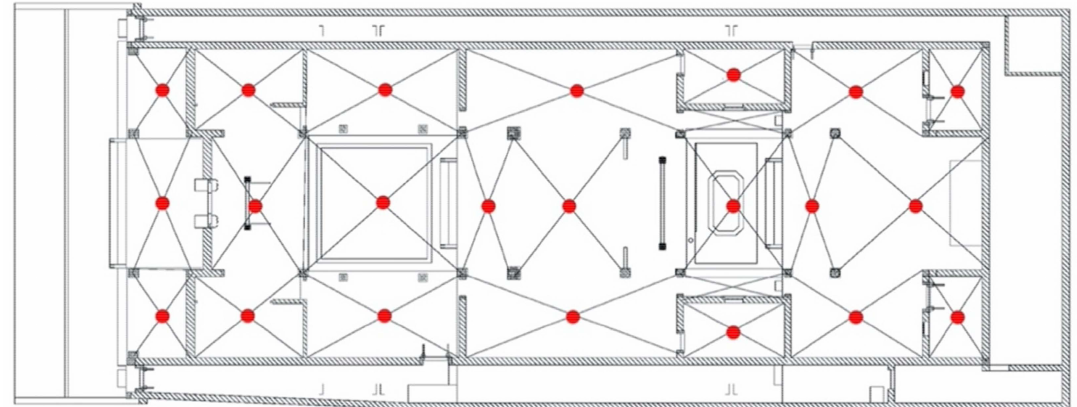
Figure 5. An example of indoor scanning. There are 22 scanning stations arranged for the indoor scanning of the Gushan